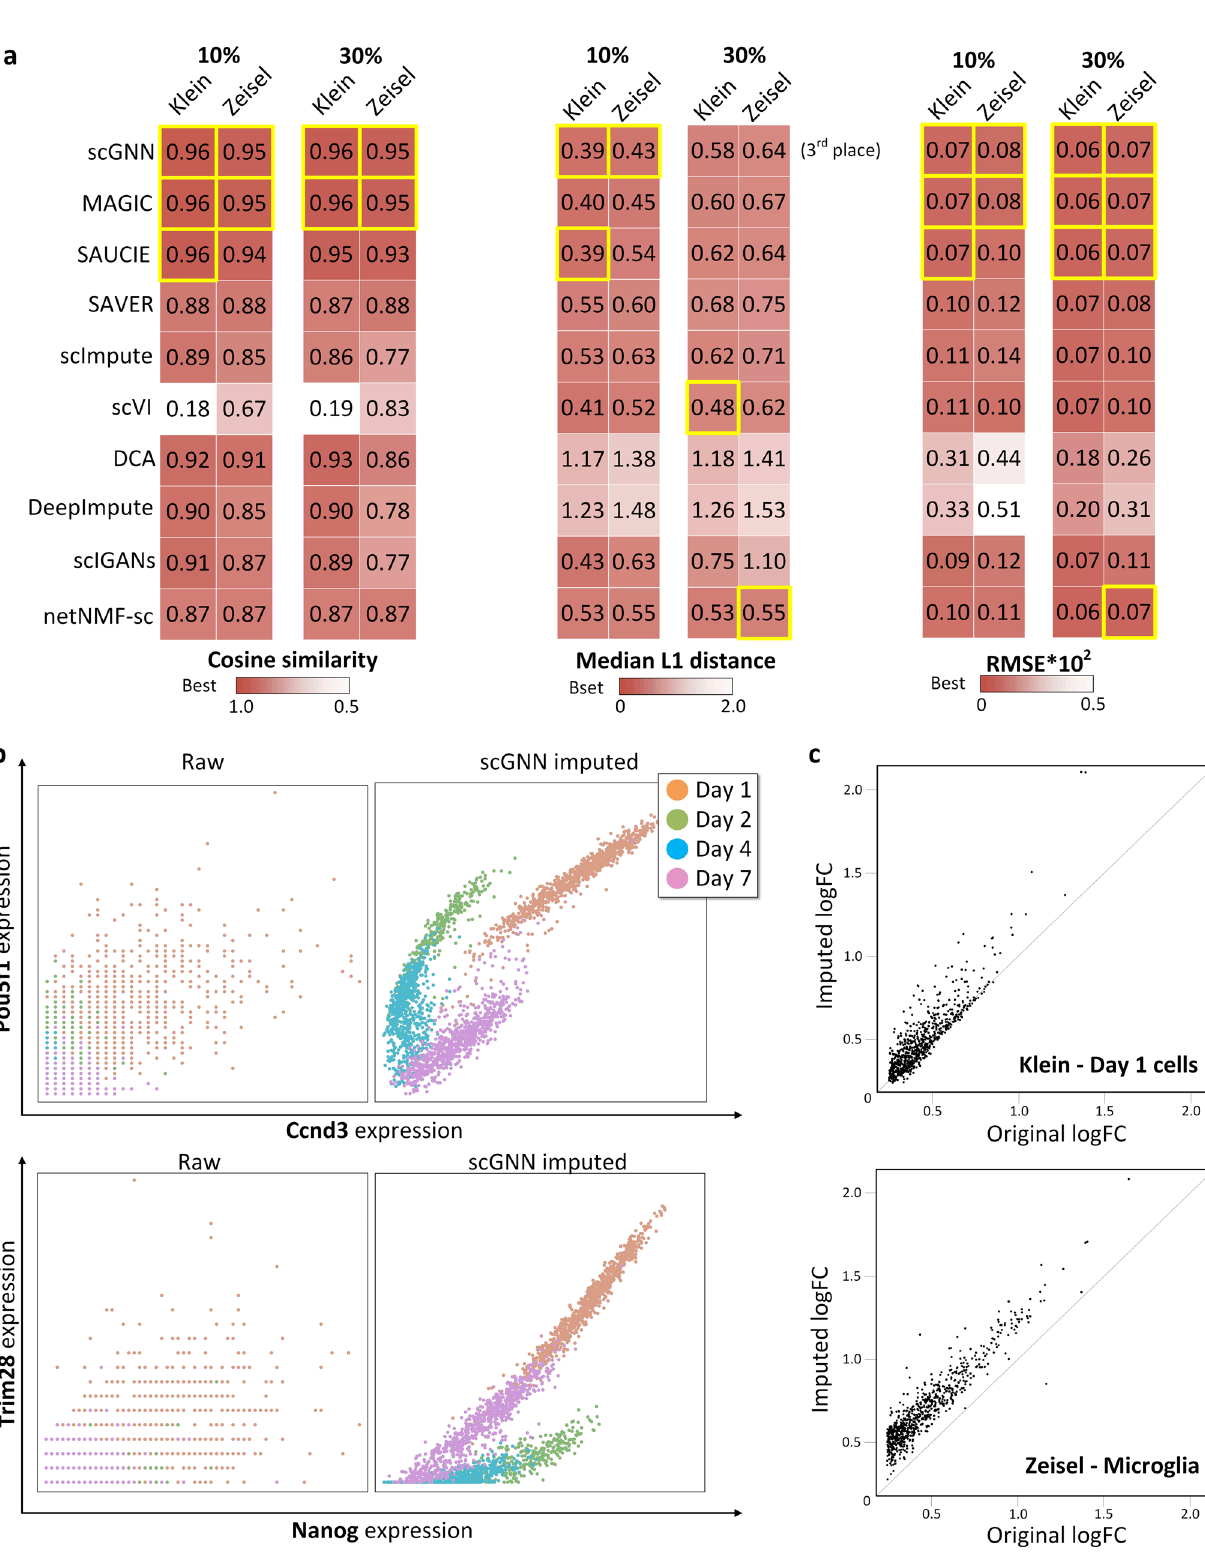
NATURE COMMUNICATIONS| (2021)12:1882|https://doi.org/10.1038/s41467-021-22197-x|www.nature.com/naturecommunications